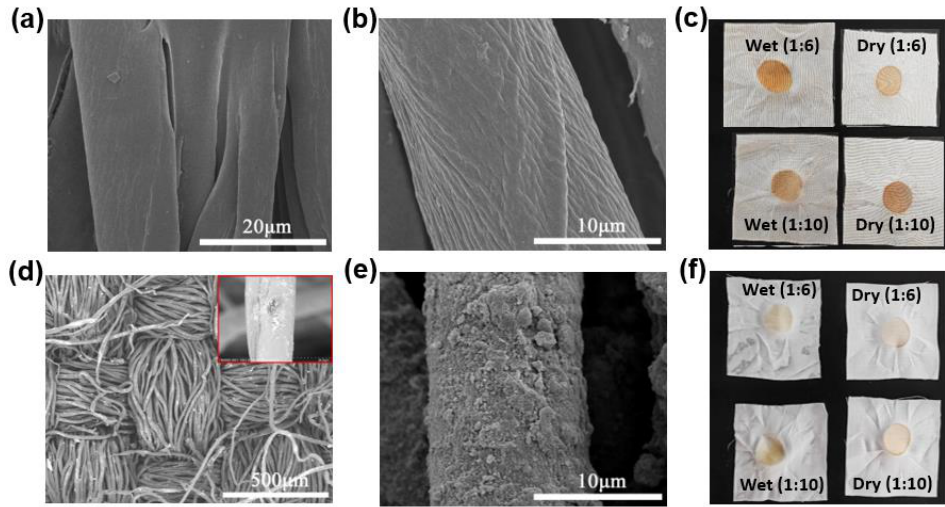
Figure 6. Characterization of the functional fabrics. SEM images of ( a ) before and ( b ) after alkali treatment; SEM images of the grafting fabrics ( d ) before and ( e ) after washing for three times; color fatness to rubbing results of ( c ) before and ( f ) after washing the fabrics for three times.